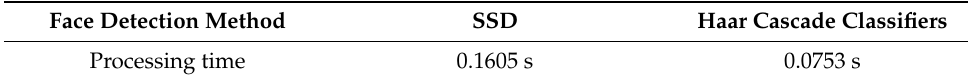
Table 1. Processing time of face detection on Raspberry Pi